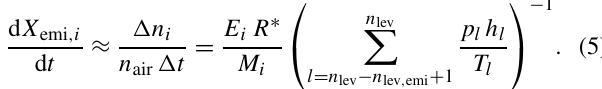
Figure 4. Content of “first_and_last_date.txt”. It commits the boundary dates of the data set to the module with first date of data set in the first line and last date in the second one. Here, an exam- ple is given for the inventory MEGAN-MACC (see Sect. 3.1.4 for further